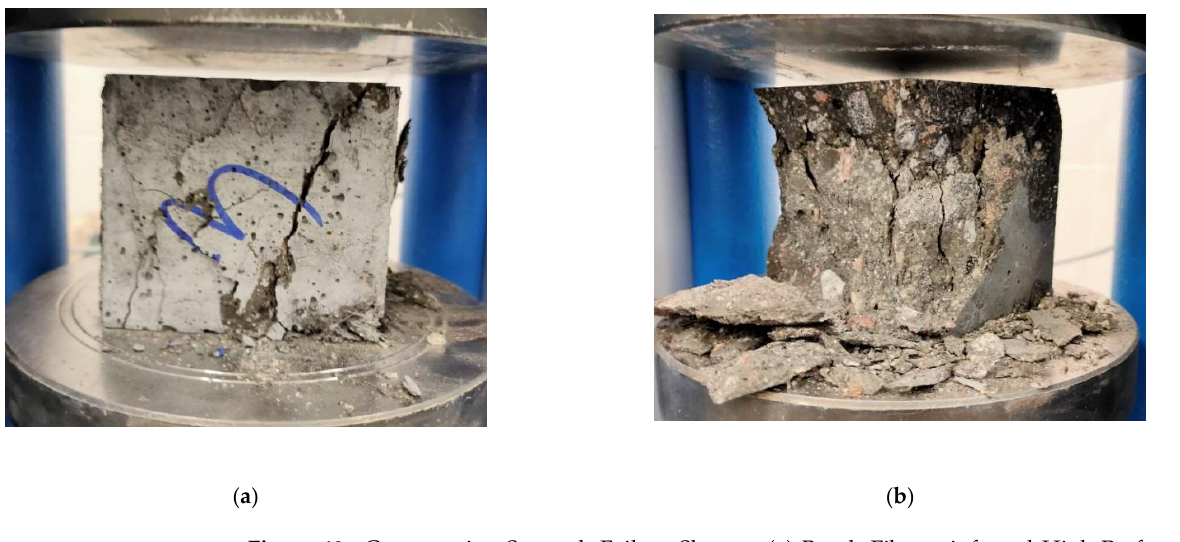
Figure 15. Flexural Strength Workability in Different Curing Periods.